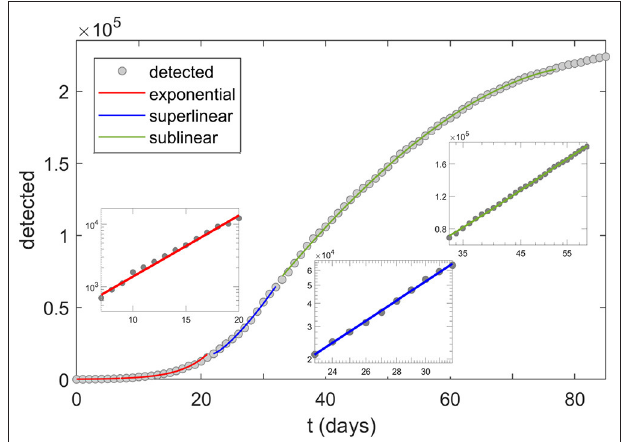
FIGURE 1 | COVID-19 growth regimes. Transitions of the growth patterns (here shown for Italy) from exponential (red), to superlinear (blue) and sublinear (green) regime. The three insets correspond to the log-linear scale (exponential), log-log scale (superlinear), and linear-log scale (sublinear). Dots correspond to detected infections, starting from 20.02.2020. In this study, R 0, free is extracted from the slope of the first (exponential, i.e., log-linear) inset, corresponding to dates 29.02–13.03 in the case of Italy.